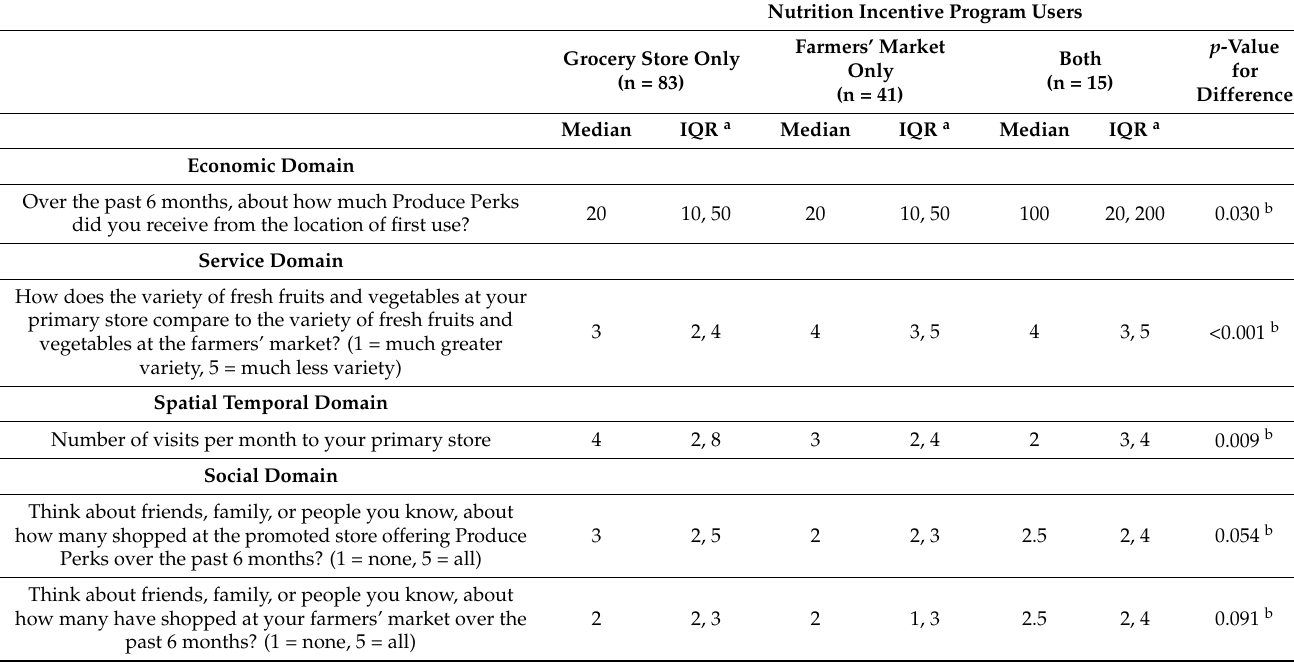
Table 3. Characteristics that differ by nutrition incentive program setting of use: grocery store, farmers’ market, or both (at p <